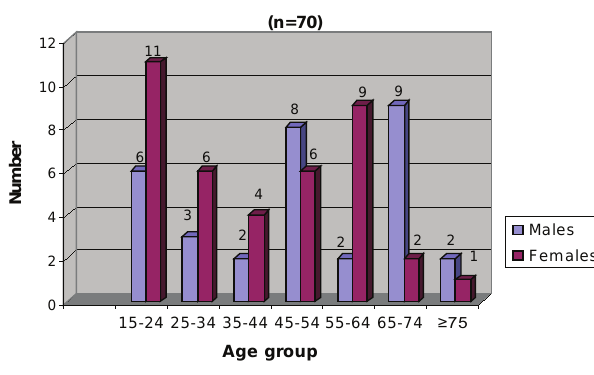
Figure 2: Age and sex distribution of cervical lymphadenopathy